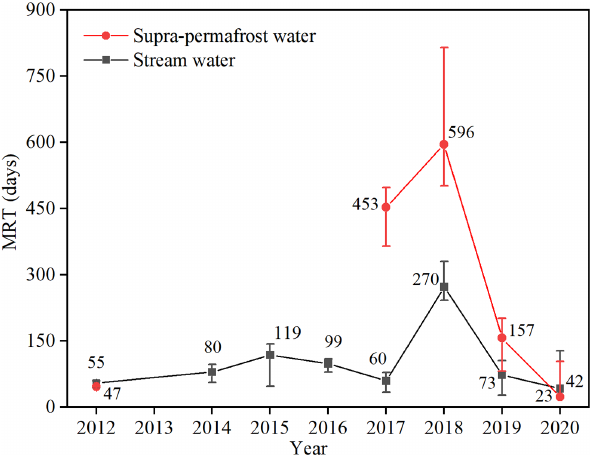
Figure 11. Inter-annual variation in stream water MRT during